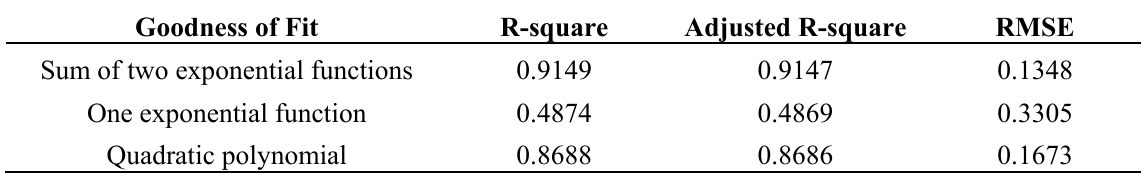
Table 1. Goodness of fit statistics used for comparing three